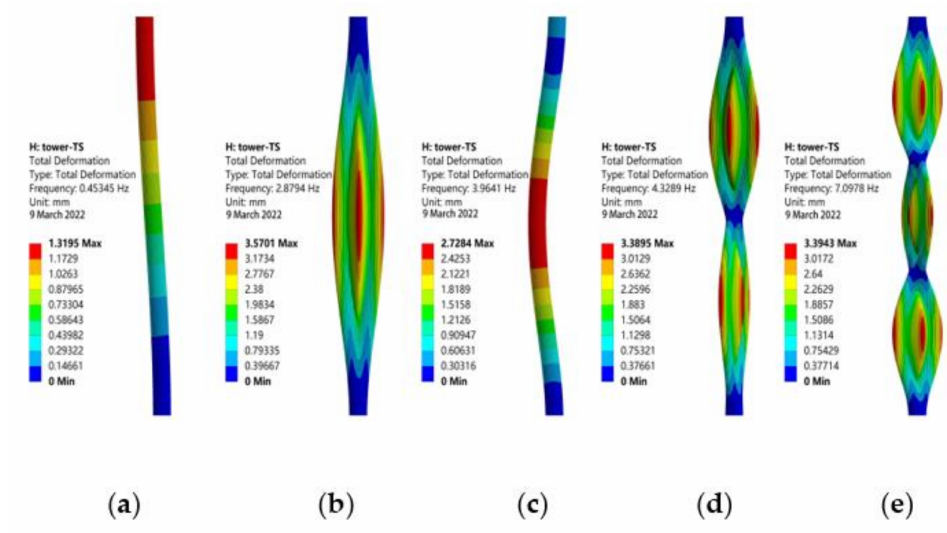
Figure 16. Mode shapes of the wind turbine with the TS–tower: ( a ) first mode; ( b ) second mode; ( c ) third mode; ( d ) fourth mode; ( e ) fifth mode.